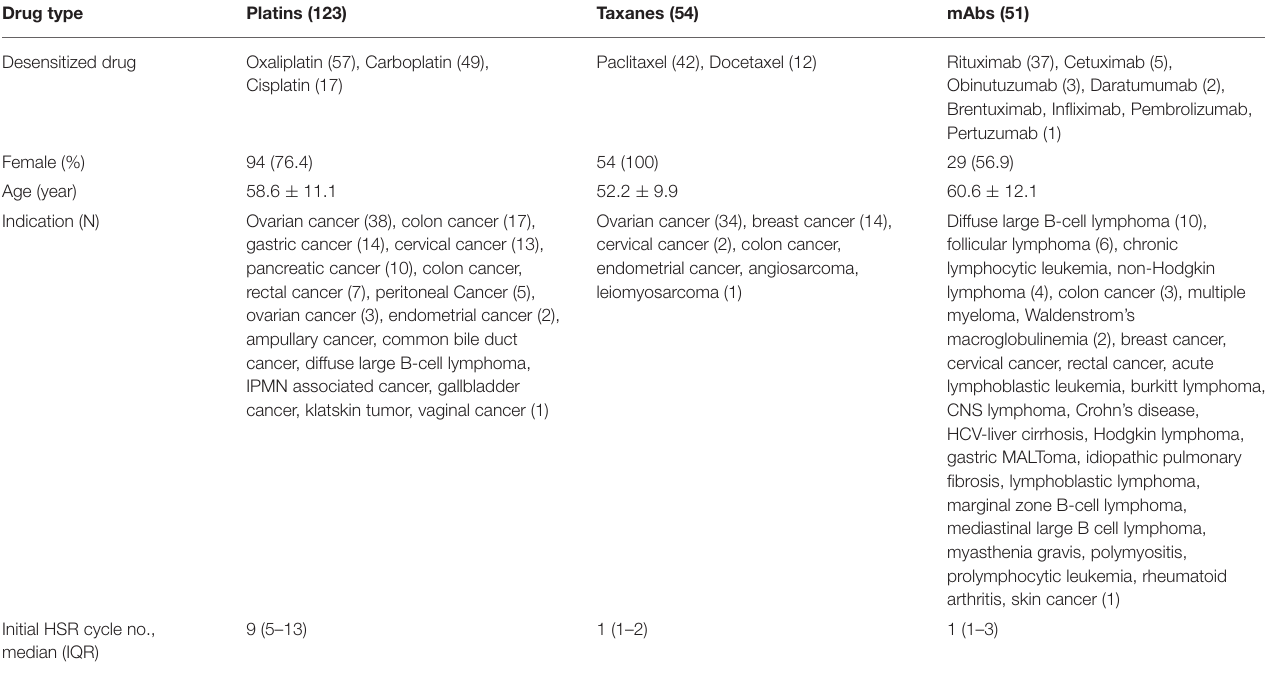
TABLE 1 | Characteristics of 228 patients included in the study.